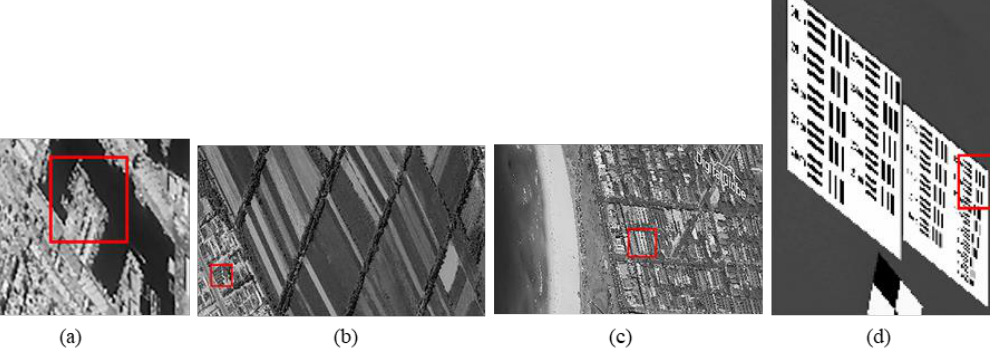
Figure 7. CMOS1 oblique-mode sampling simulation images: ( a ) seashore remote-sensing image, the chosen area is an offshore structure in an Egyptian port; ( b ) farmland remote-sensing image, the selected area is the crops and houses in Xinjiang, China; ( c ) city remote-sensing image, the selected area is buildings in Sydney; ( d ) target image, the selected area is minimum resolvable line